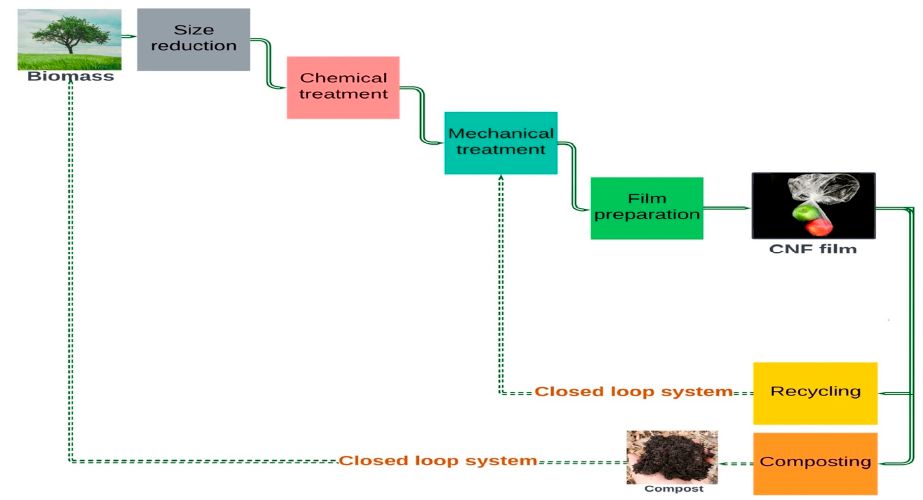
Figure 2. Generic CNF film processing from LC and end-of-life treatments.